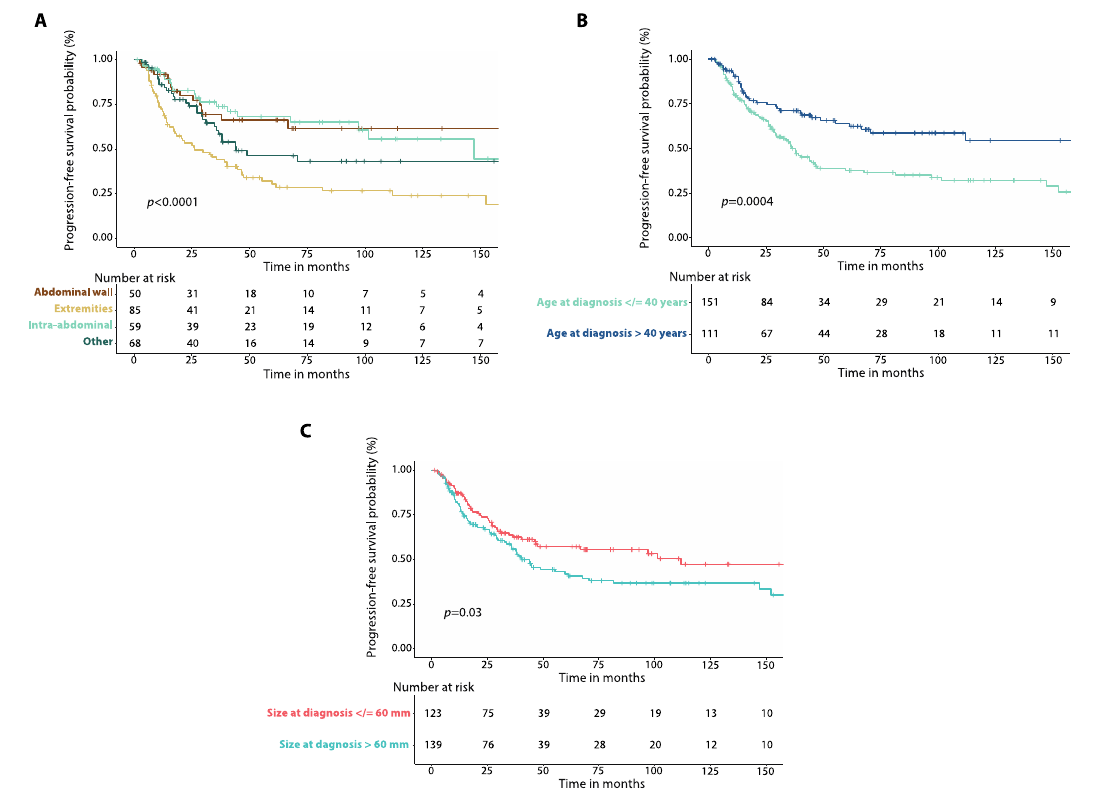
Figure 2. ( A ) Kaplan–Meier curves show progression ‐ free survival (PFS) in patients with intra ‐ abdominal desmoid tumors (DTs) compared to those with DTs of the extremities, DTs of the abdominal wall and DTs affecting other locations. ( B ) Kaplan–Meier curves show progression ‐ free survival (PFS) in patients with DTs and age at diagnosis equal to or lower than 40 years compared to those with age at diagnosis greater than 40 years. ( C ) Kaplan–Meier curves show progression ‐ free survival (PFS) in patients with DTs of size at diagnosis equal to or smaller than 60 mm com ‐ pared to patients with tumor size greater than 60 mm. p ‐ values were calculated with the Log ‐ Rank method.